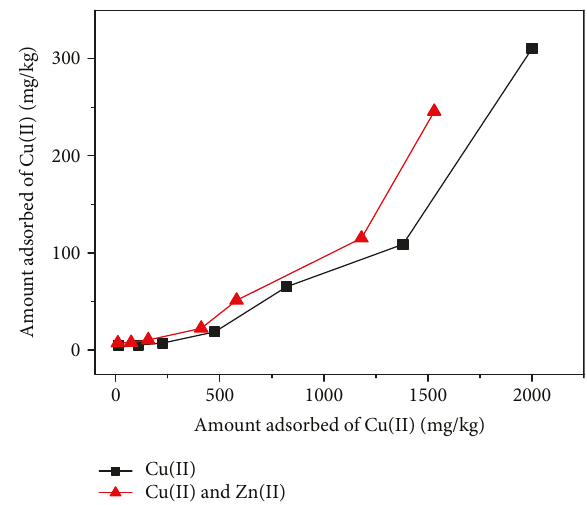
Figure 10: E ff ect of organic matter on desorption.